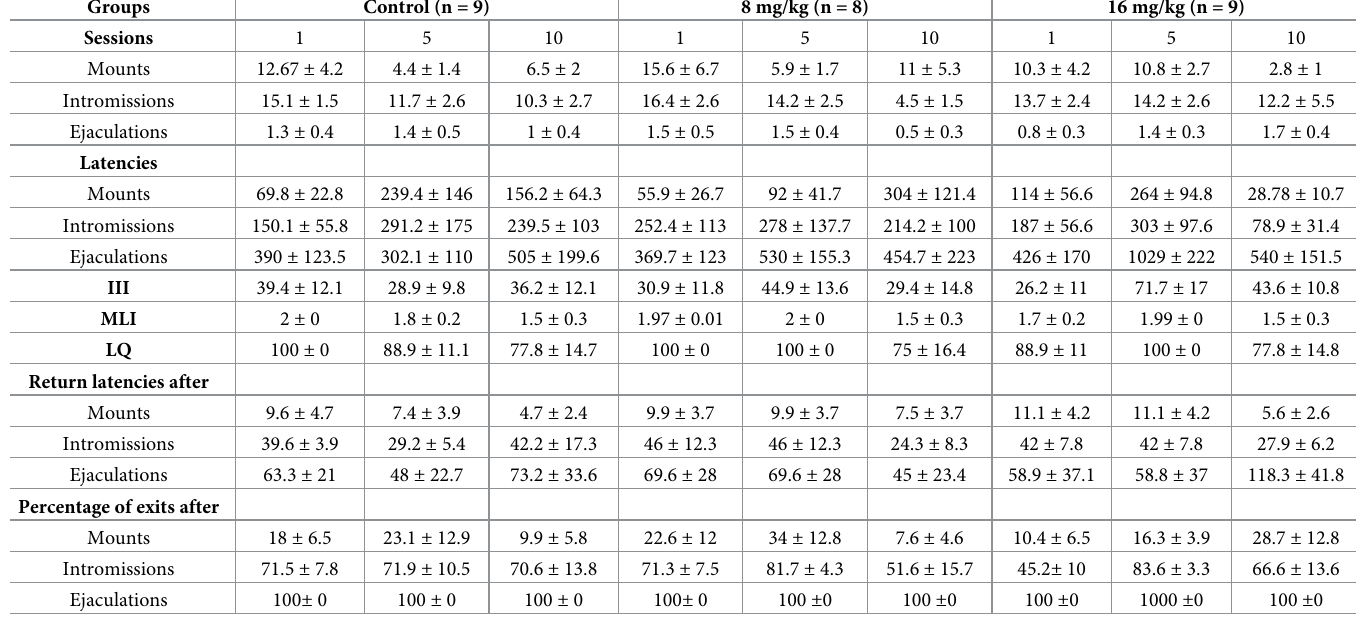
Table 1. Sexual behavior parameters in sessions 1, 5 and 10, in females treated with saline, 8 or 16 mg/kg of MnCl 2 24 hours before testing with a sexually experi- enced male in experiment 1. Data are expressed as mean ± SEM. (III: Inter intromission interval; MLI: Mean lordosis intensity; LQ: Lordosis quotient).